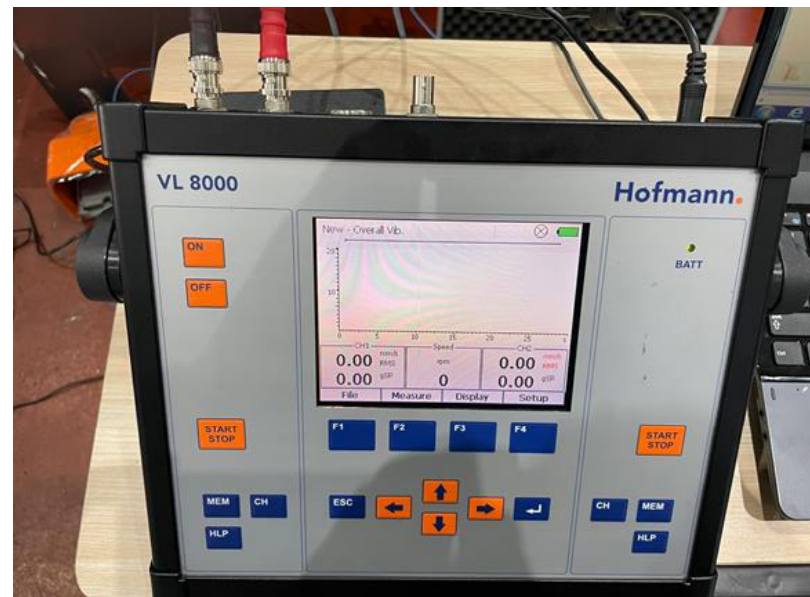
Figure 5. Vibration measurement device.